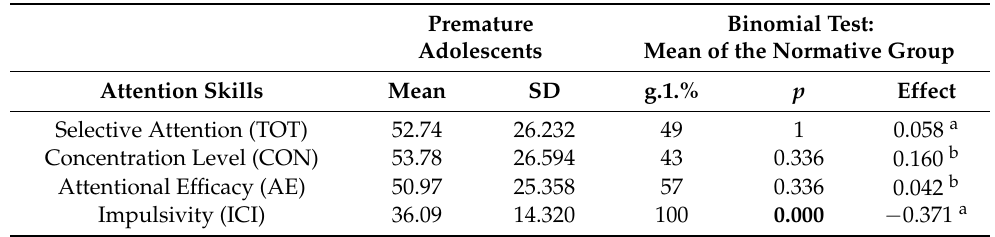
Table 3. Comparison of the average percentiles index of attentional skills in adolescents born prematurely and the average percentiles of D2 and CARAS-R tests. Premature Binomial Test: Adolescents Mean of the Normative Group Attention Skills Mean SD g.1.% p Effect Selective Attention